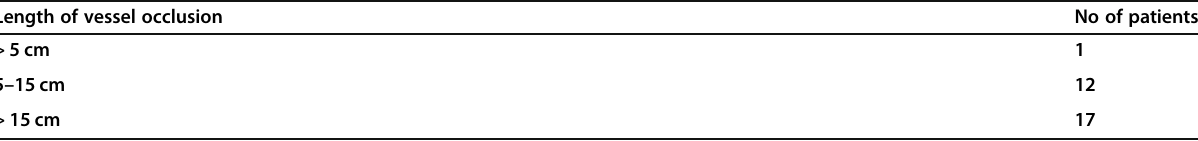
Table 4 Length of occlusion Length of vessel